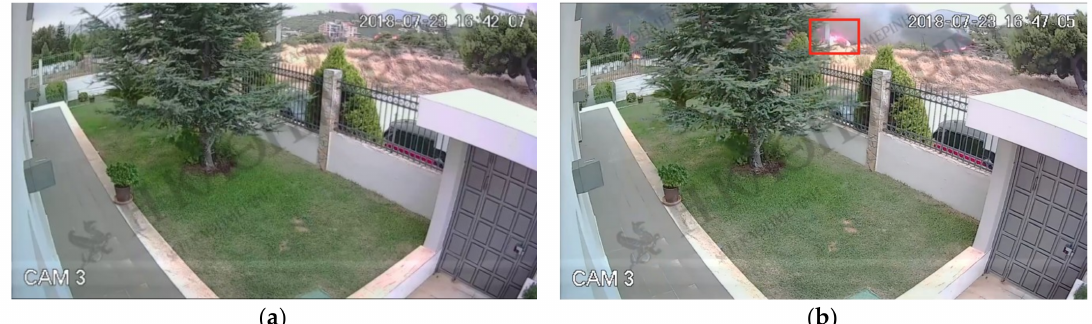
Figure 17. Two sample snapshots capturing the start of the Mati-Rafina fire incident on 23/7/2018: ( a ) when the fire is still far from the specific premise and ( b ) 5 min later, when the fire is closer and the flames are well visible.